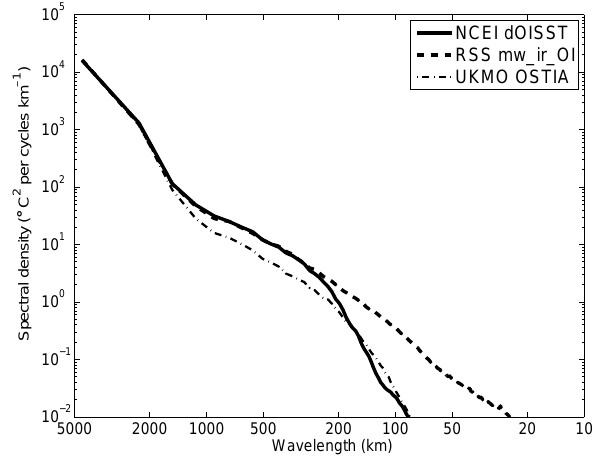
Figure 4. Power spectra of three analyzed SST fields from the first 2 months of 2016. See text for explanation of data sets used. At smaller scales, the spectrum of the RSS product that ingests high-resolution inputs (1km MODIS SSTs) continues to display the same spectral slope into the smaller-scale range. MODIS SSTs are available only from